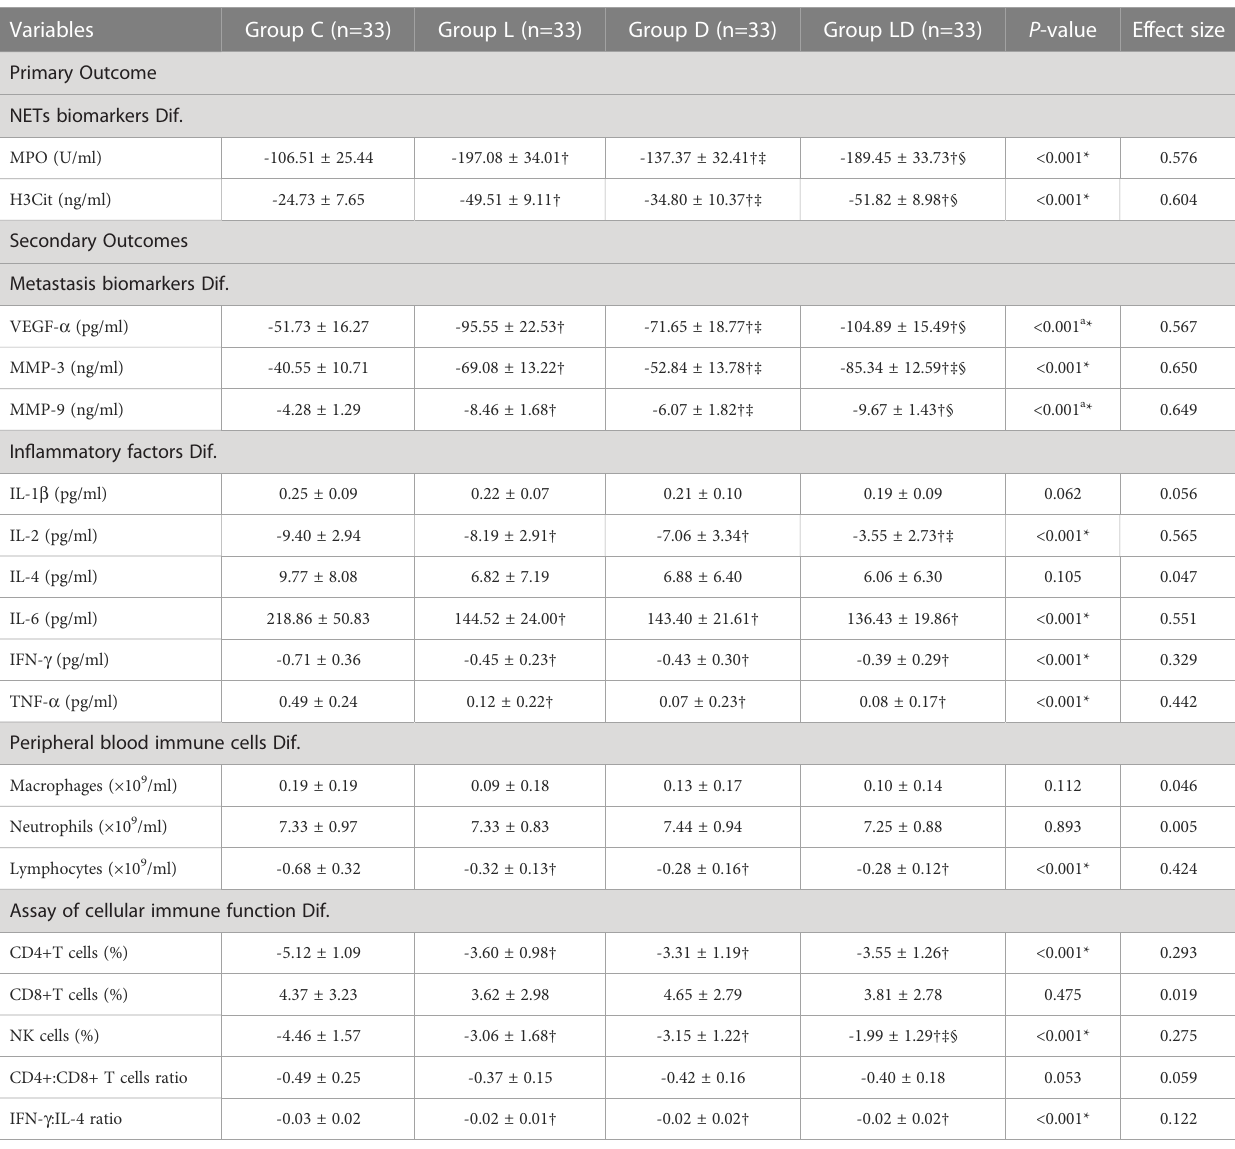
TABLE 3 Primary outcome and secondary outcomes.